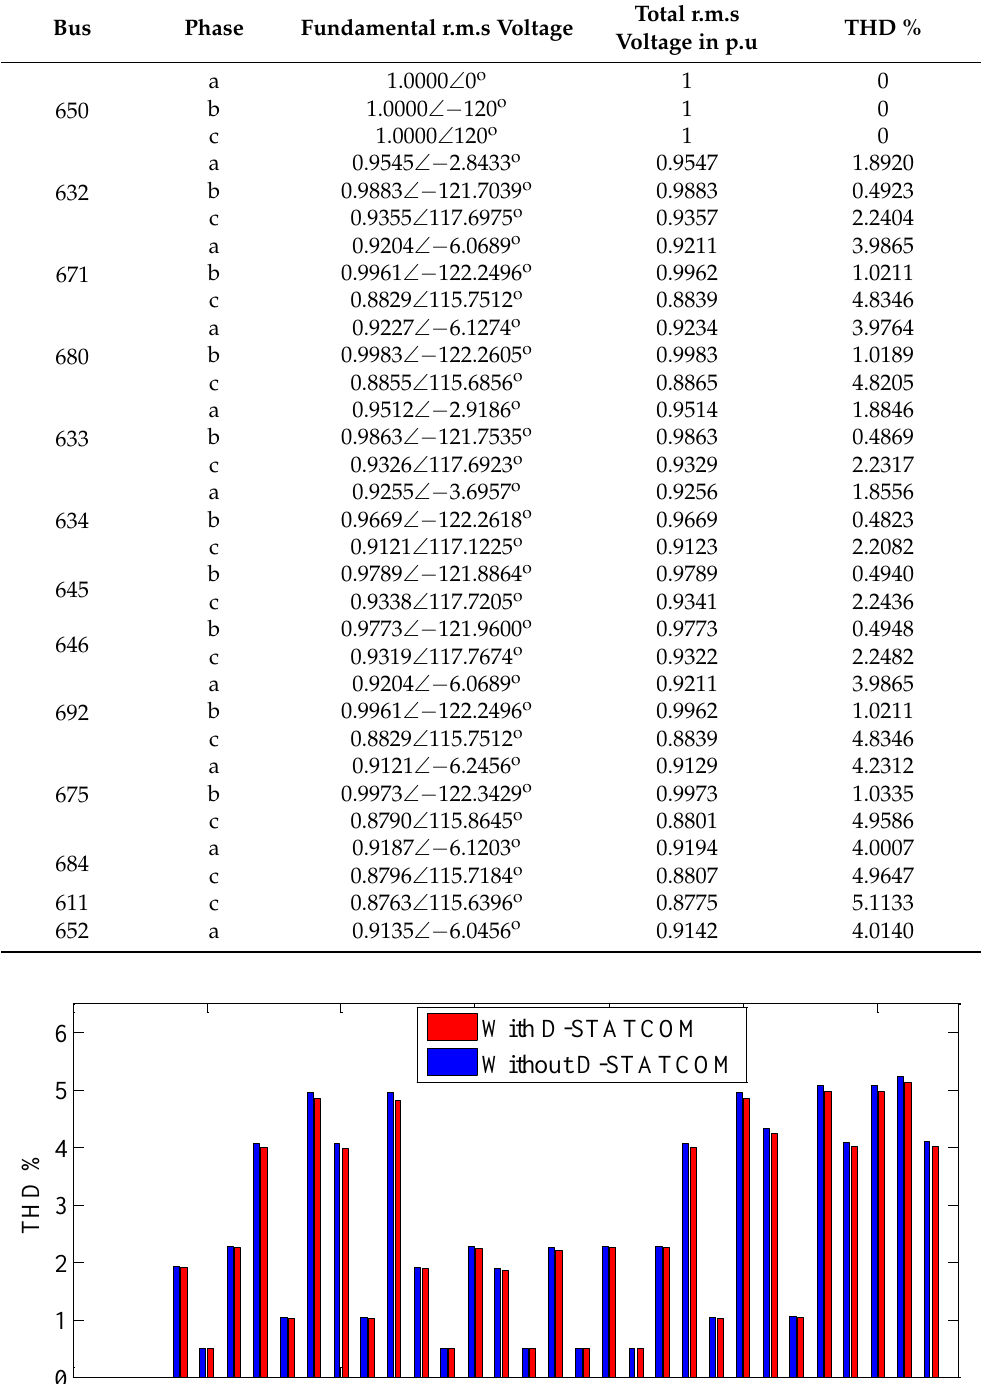
Table 9. Fundamental r.m.s voltages, total r.m.s voltages, and THD % in IEEE − 13 bus URDN with